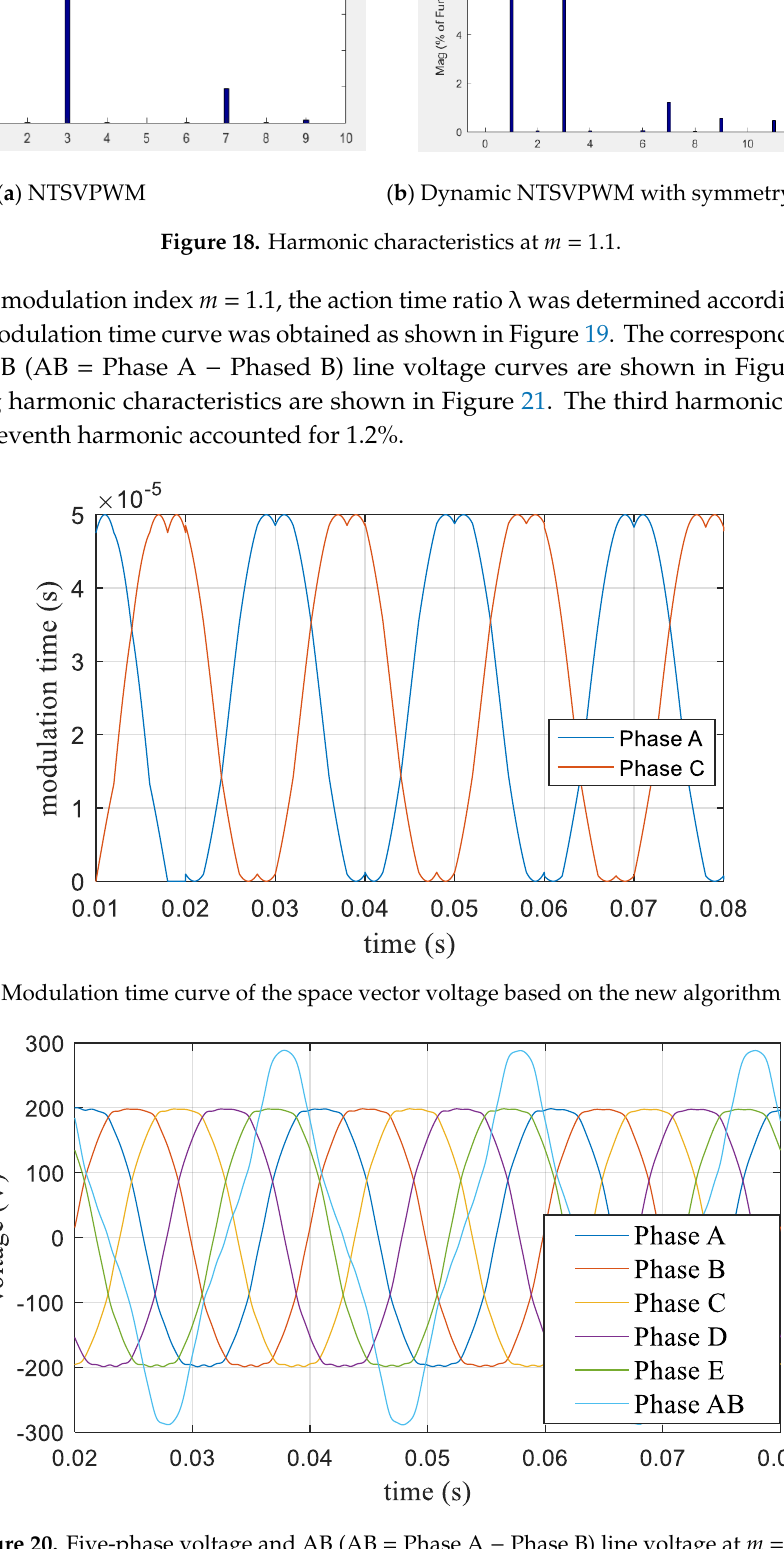
Figure 17. A and B phase voltage at m = 1.1.